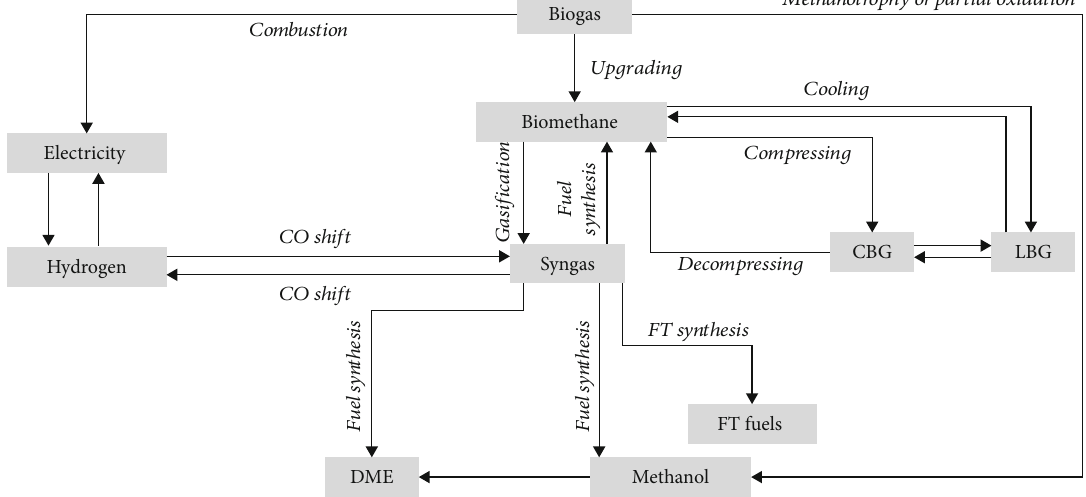
Figure 15: Pathways for biogas conversion to transportation fuels